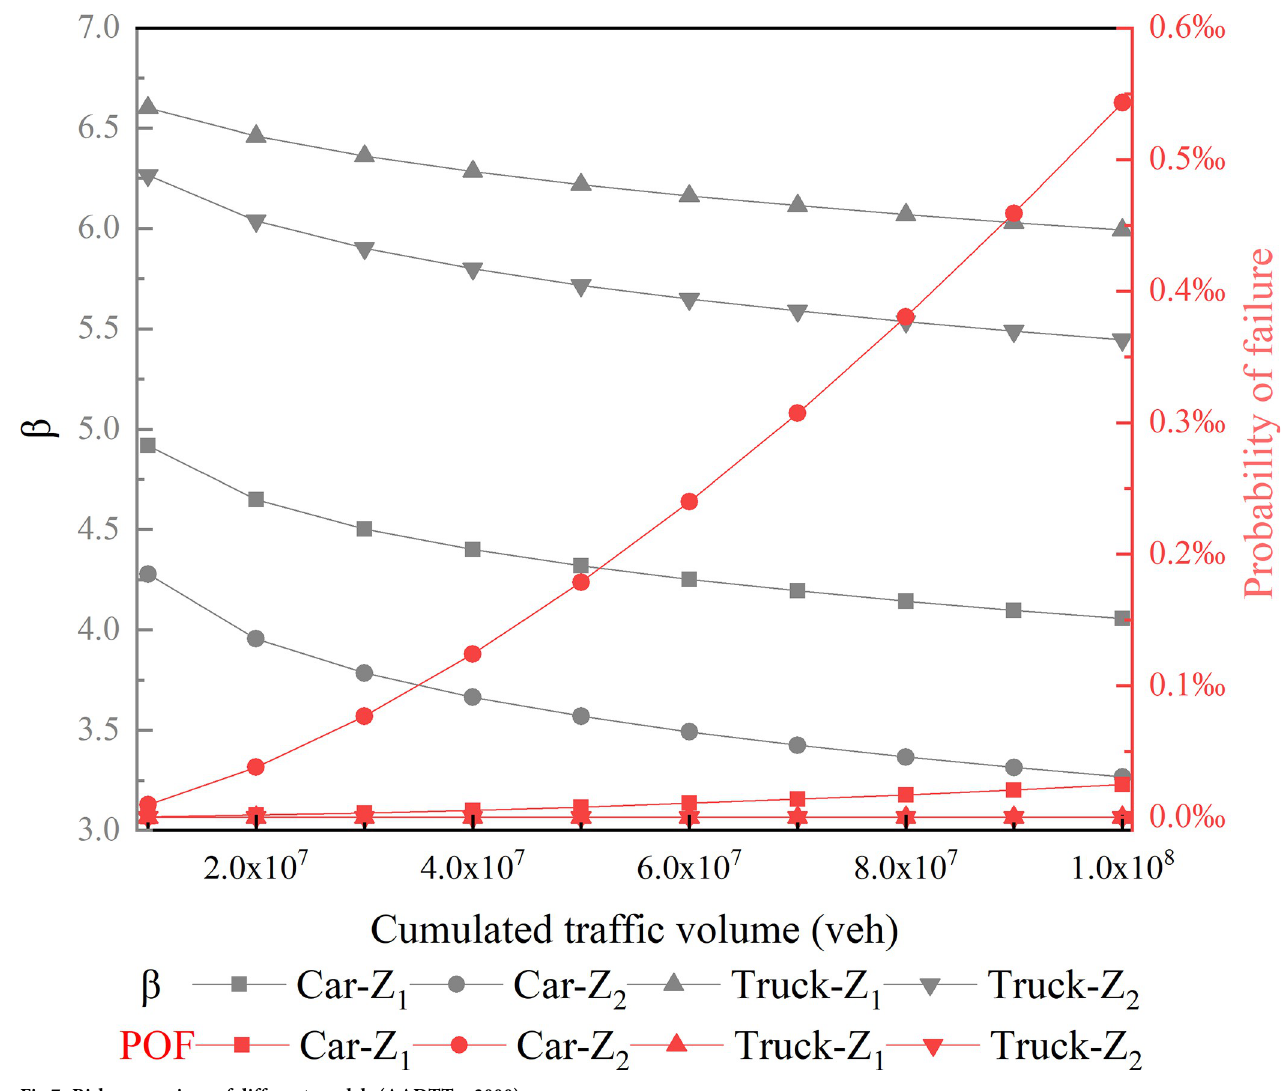
Fig 7. Risk comparison of different models (AADTT =